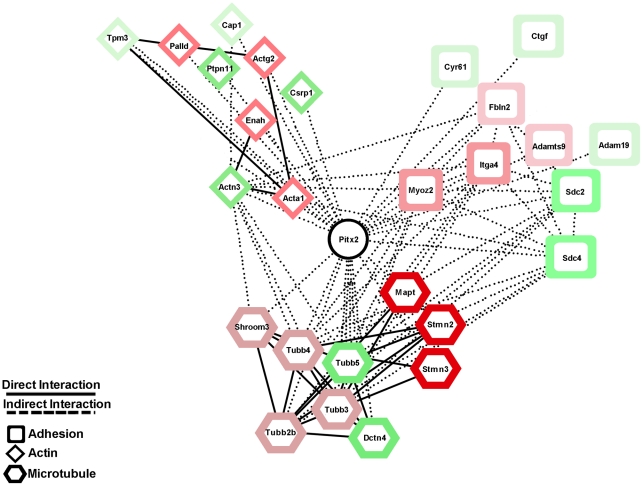
Pitx2-Mediated Myogenic Cell Gene Network During Filling Limb Muscle Anlagen.The network displays ten genes with the greatest fold change from each of the three groups; actin (diamonds), microtubule (octagons) and adhesion (squares) related genes. Color intensity is representative of reported fold change based on their gene expression analysis (Table 1), with darker color representing larger fold change. Connections between the nodes are displayed as solid lines for direct interactions and dashed lines for possible interactions.